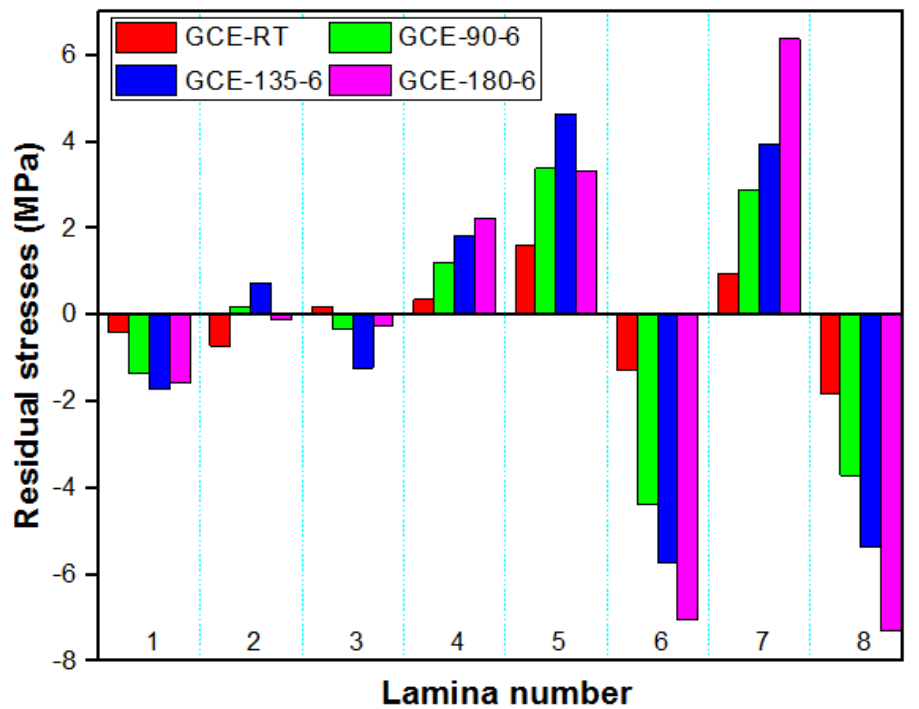
Figure 7. Transverse residual stress in each lamina determined from recorded transverse strains for all GCE laminates.